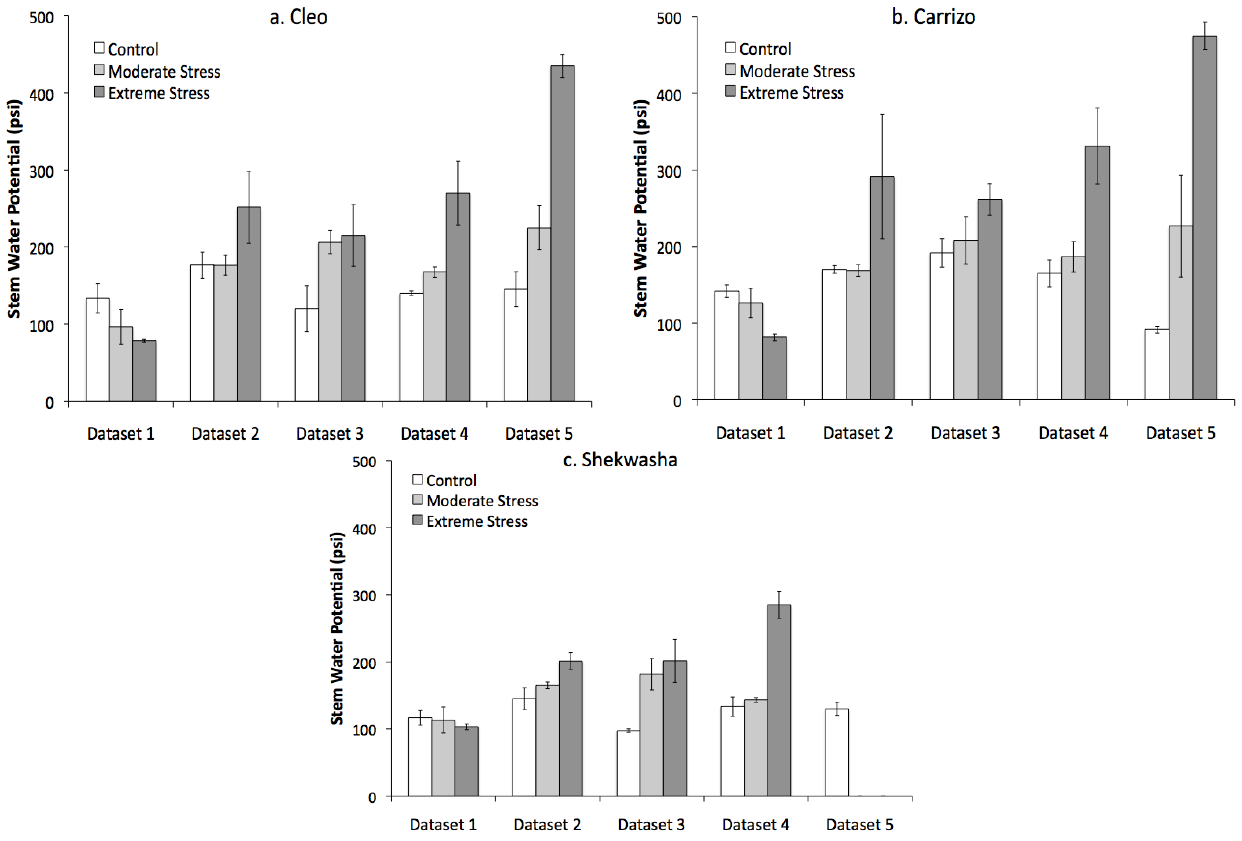
Figure 1. Stem water potential measurements collected throughout the experiment for